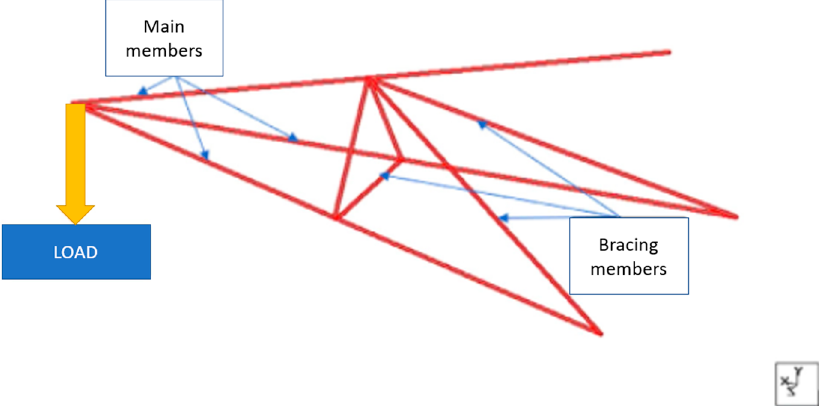
Figure 18. Final design of bracing cross arms in 132 kV transmission tower [29]. Reproduced with